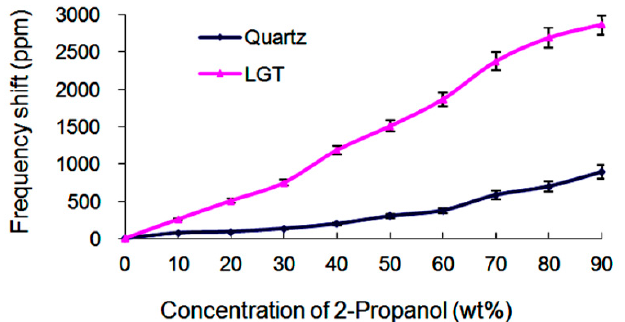
Figure 5. Frequency changes of different LFE devices for different concentrations of 2-propanol aqueous solutions.